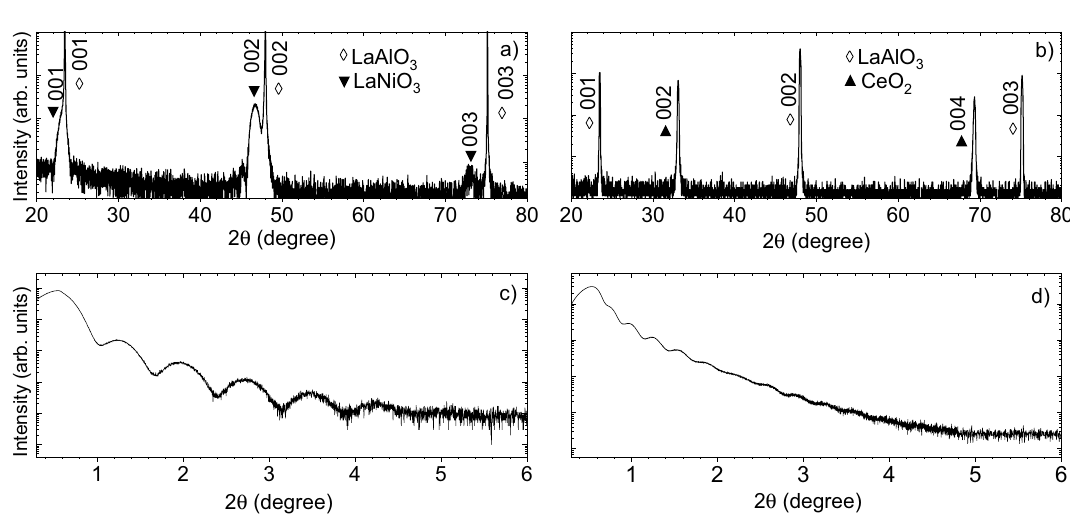
Figure 4. θ − 2 θ out-of-plane X-Ray Diffraction of the LNO ( a ) and CeO 2 ( b ) films grown on LAO [0 0 1] substrate, showing only (0 0 l ) diffraction peaks; typical low-angle x-ray reflectivity curves of LNO ( c ) and CeO 2 ( d ) film displaying clear oscillations up to 2 θ of 4